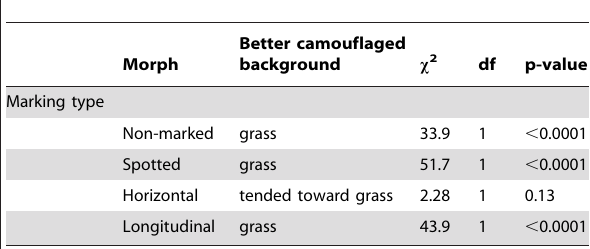
Table 2. The effect of background on crypsis for each morph.